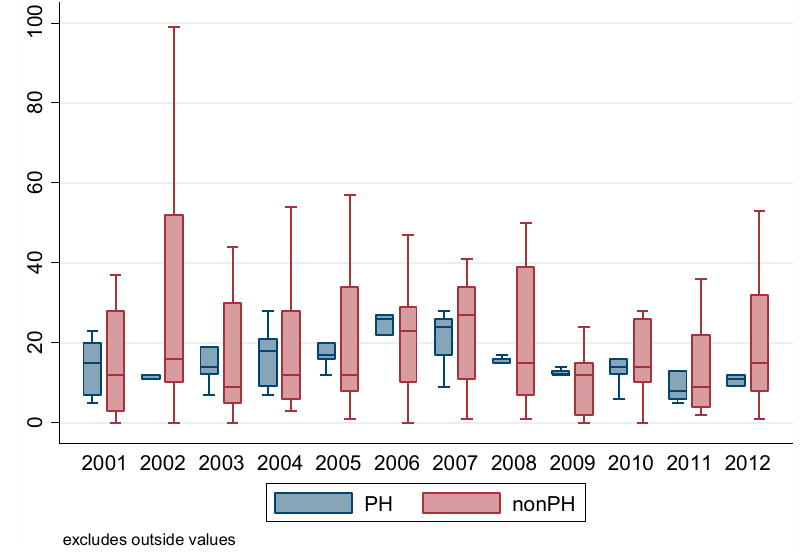
Figure 6. Drug arrests in public housing by year. Table 6. Arellano-Bond dynamic panel-data models predicting drug arrests.